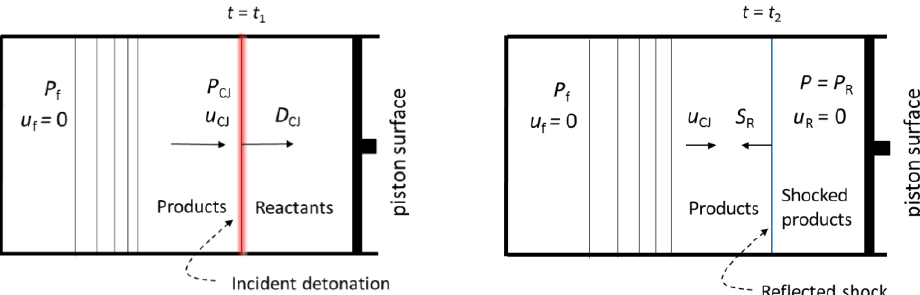
Figure 2. A sketch showing different gas dynamic states of the detonation reflection process.